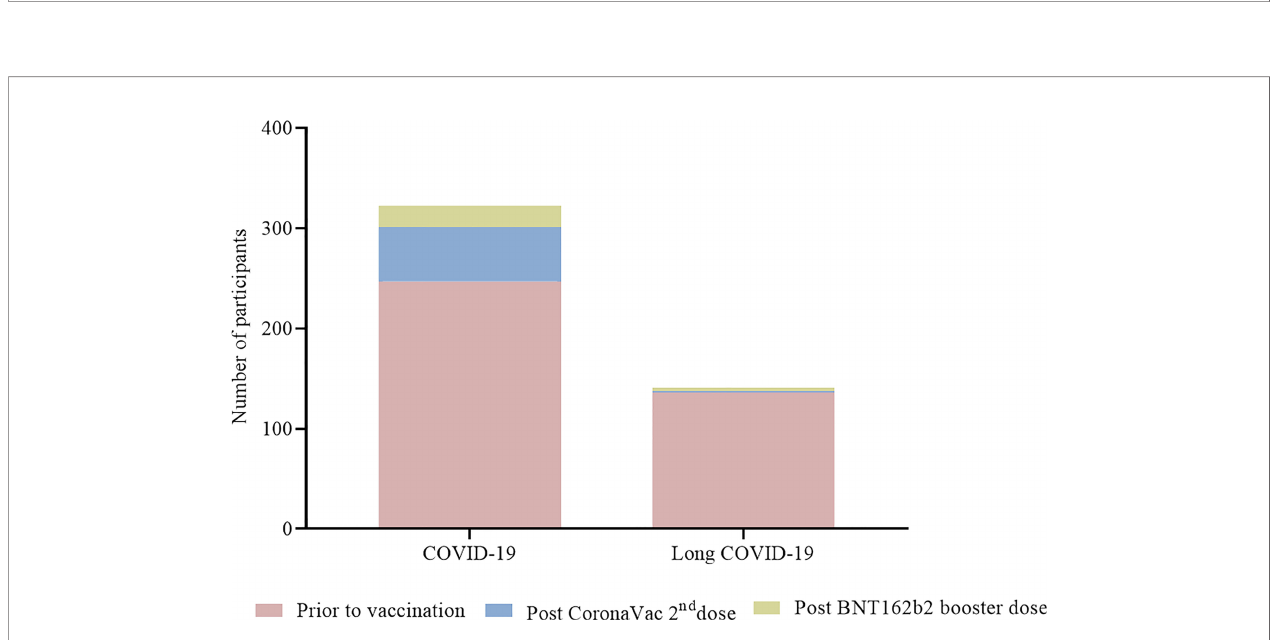
FIGURE 7 | Adverse events in the fi rst 7 days after vaccination. Participants were vaccinated with CoronaVac two-dose regimen and BNT162b2 booster dose. Most frequent adverse events are described for CoronaVac ( ) and BNT162b2 (